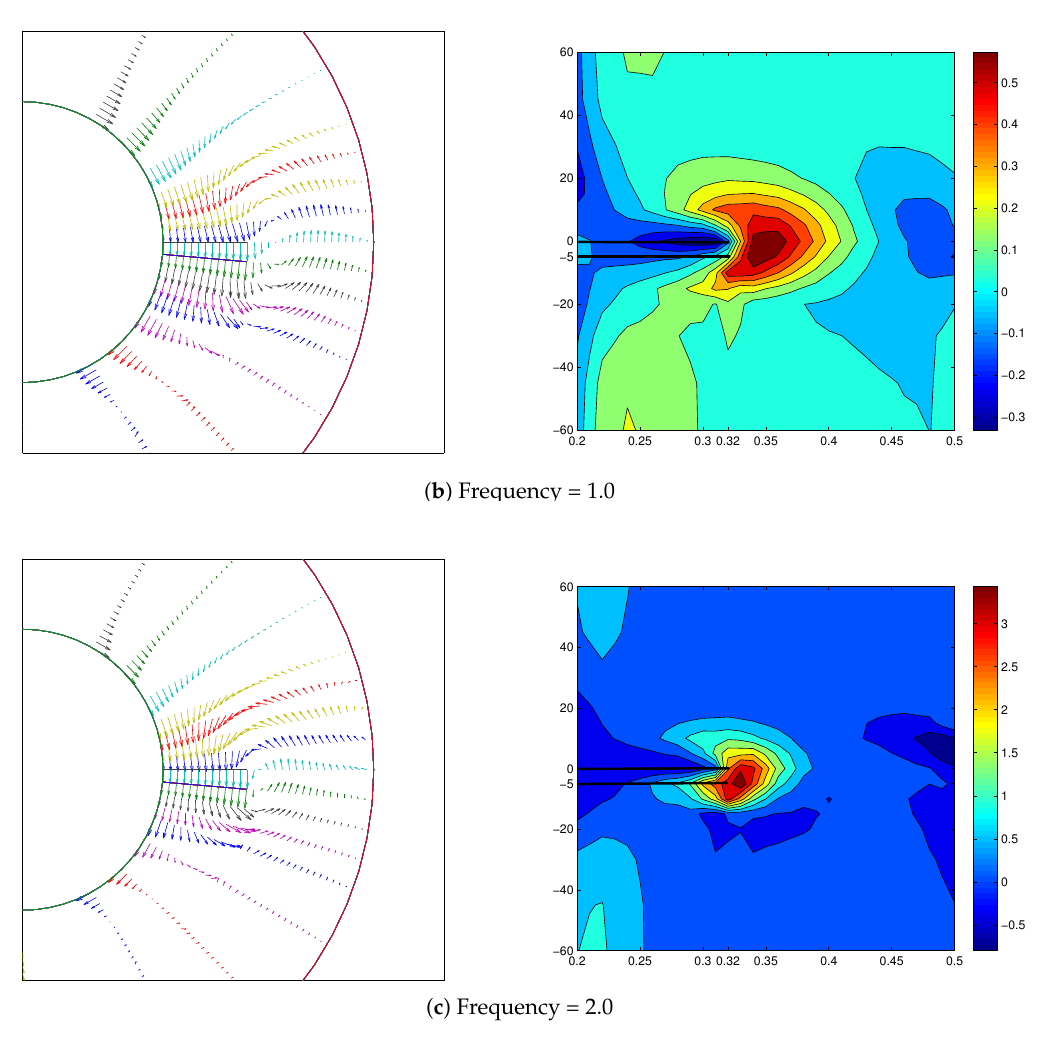
Figure 4. Velocity field and vorticity contours in the vicinity of the plate for various frequencies at t = 12. ( a ) Frequency = 0.5; ( b ) Frequency = 1.0; ( c ) Frequency =